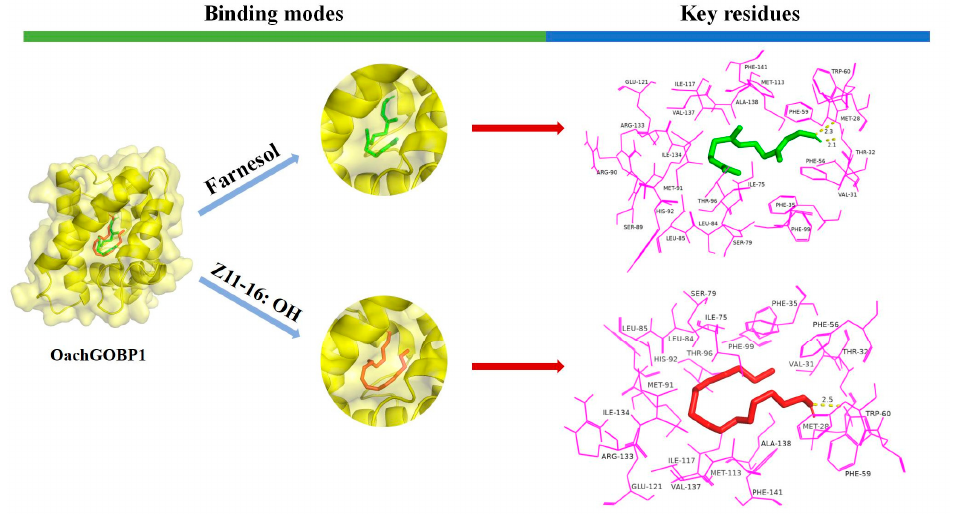
Figure 6. Binding modes and key residues of OachGOBP1 with different ligands: Farnesol (green) and Z 11–16: OH (red) in the putative binding pocket of chain A of OachGOBP1. The key residues of the different ligands that interact with OachGOBP1. The residues within 4 Å of the ligands are highlighted in magenta. (For interpretation of the references to color in this figure legend, the reader is referred to the web version of this article.)